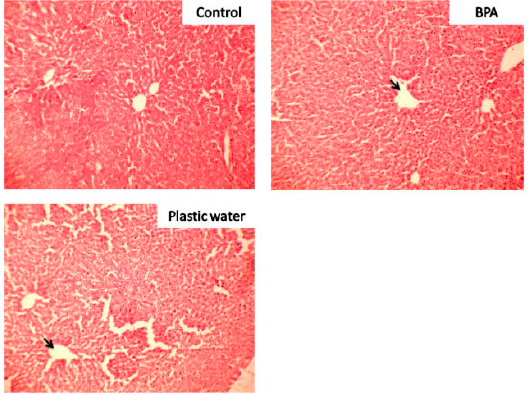
Figure 3. Photomicrograph of liver of rats magnified 100 × . The black arrows show dilatation of the